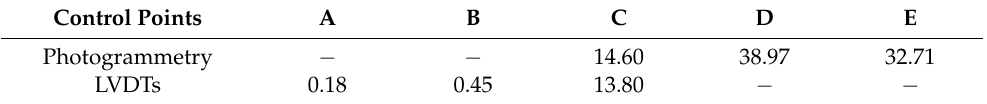
Table 2. Displacement of the deformation control points A, B, C, D and E (in mm). Control